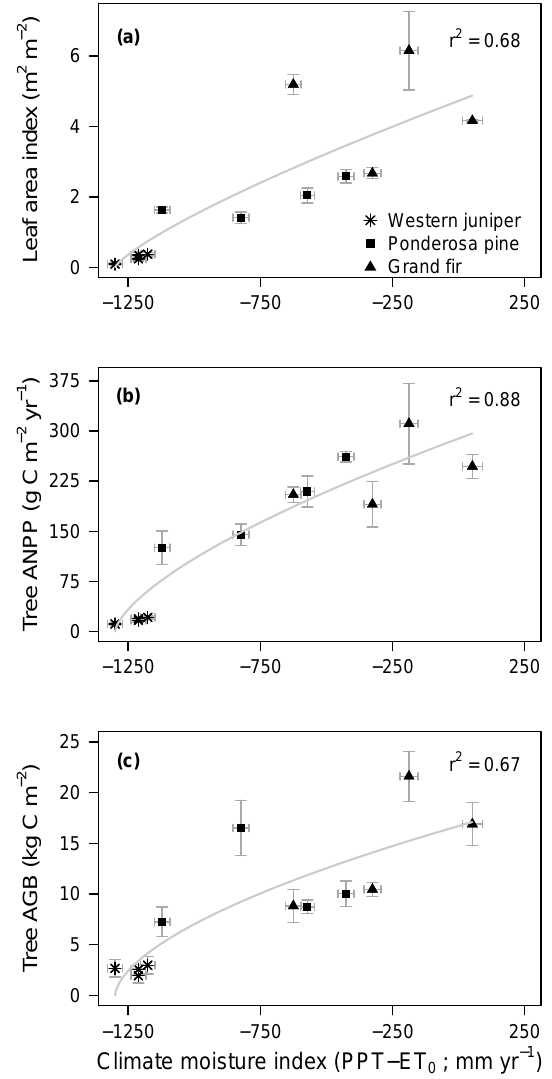
Figure 3. Forest community (a) leaf area index, (b) 10-year average annual aboveground net primary production and (c) aboveground live biomass plotted against the average growing-year climate mois- ture index from 1964 to 2013 (CMI gy ) for 12 mature conifer sites in the eastern Cascade Mountains, Oregon. We calculated CMI gy by summing monthly precipitation (PPT) minus reference evapo- transpiration (ET 0 ) from October to through September and then averaged the growing-year values from 1964 to 2013. Each point represents the mean ( ± 1SE) of four subplots. Regression coeffi- cients are given in Table